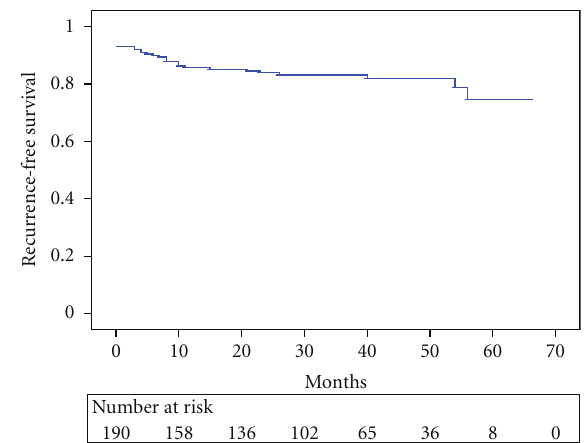
Figure 1: PSA recurrence-free survival after EPLRP in Taiwanese men.